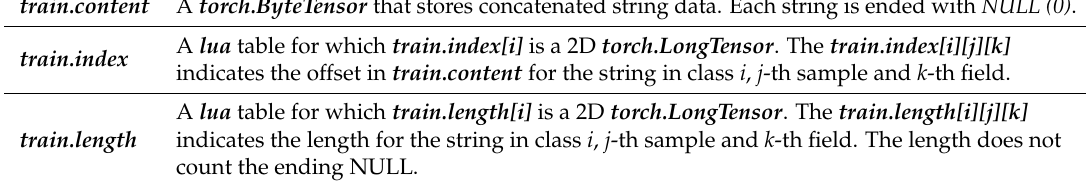
Table A2. Members of the variable train .